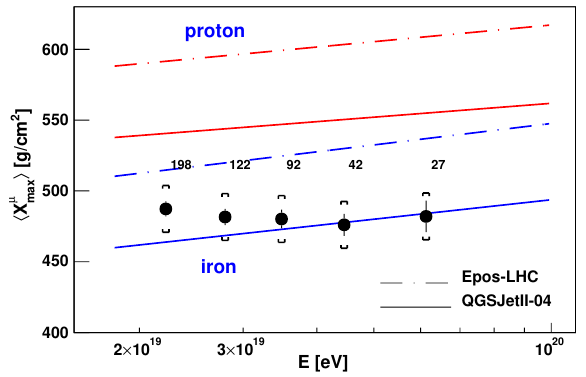
(cid:105) as a function of the primary energy. The predic- Figure 8. (cid:104) X µ max tion of di ff erent hadronic models for proton and iron are shown. Numbers indicate the number of events in each energy bin and brackets represent the systematic